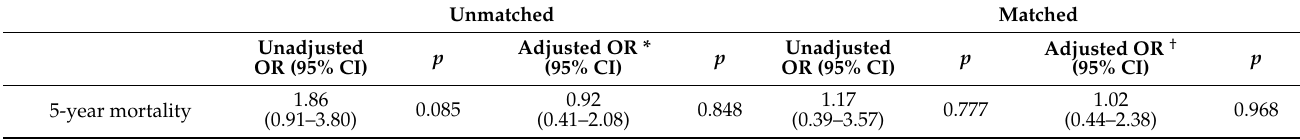
Table 4. The 5-year mortality adjusted by laparoscopic